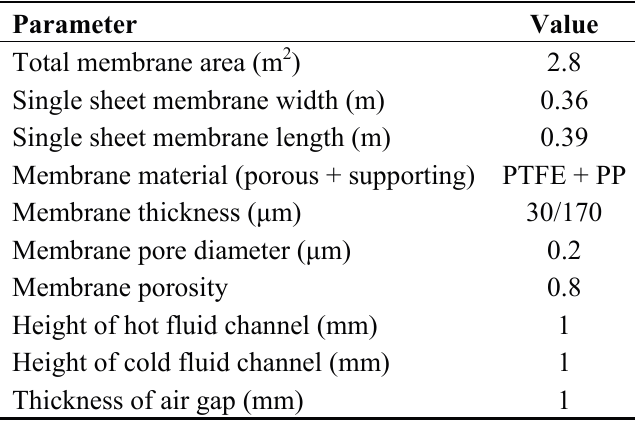
Table 1. Attributions of the AGMD